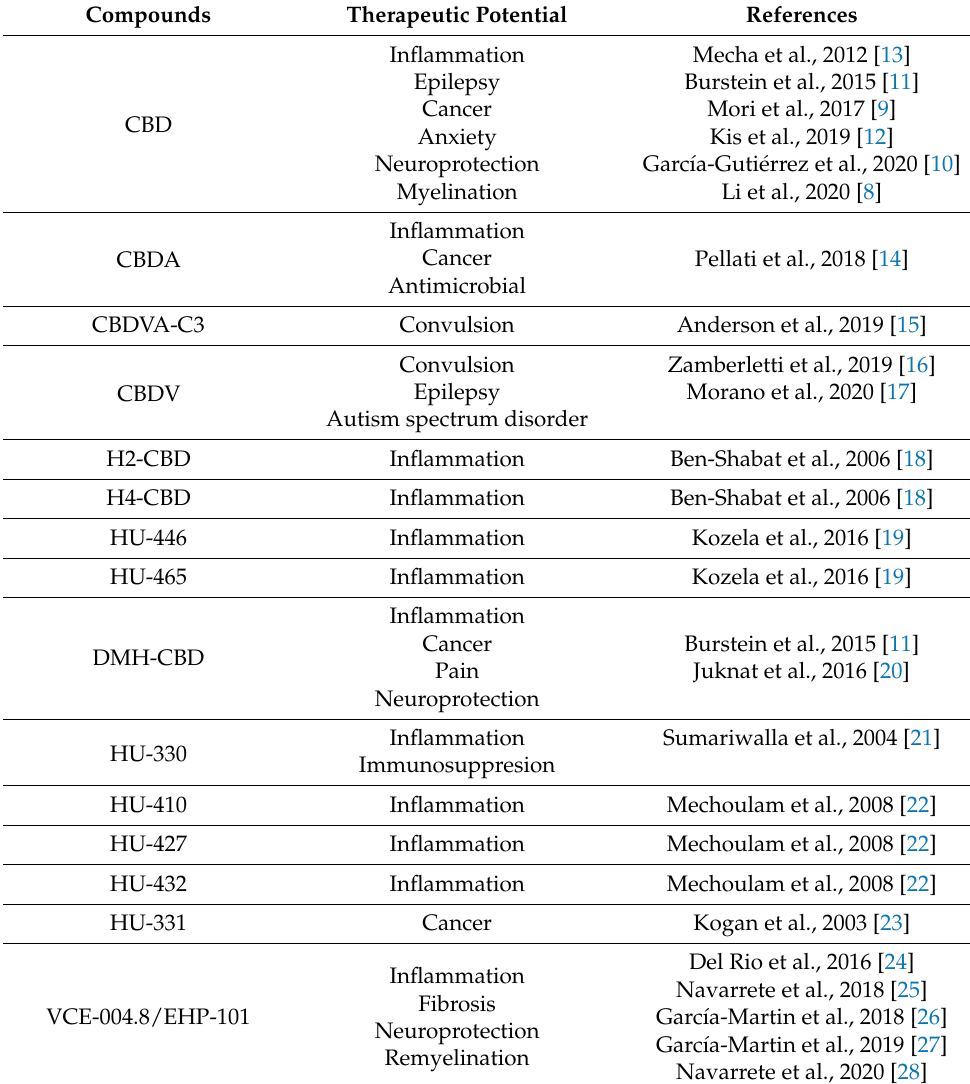
Table 1. Therapeutic potential of CBD, analogs, and